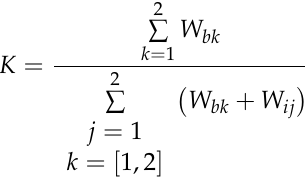
Figure 4. Evaluation Procedure.